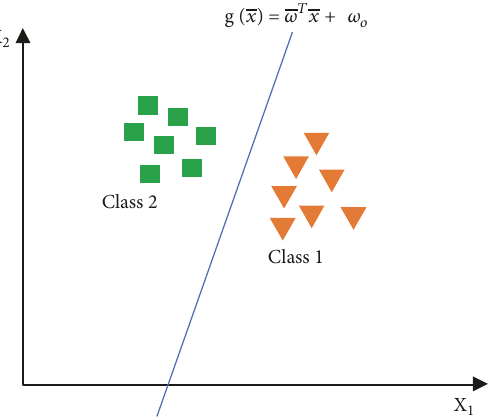
Figure 3: Hyperplane classifies data into two classes.